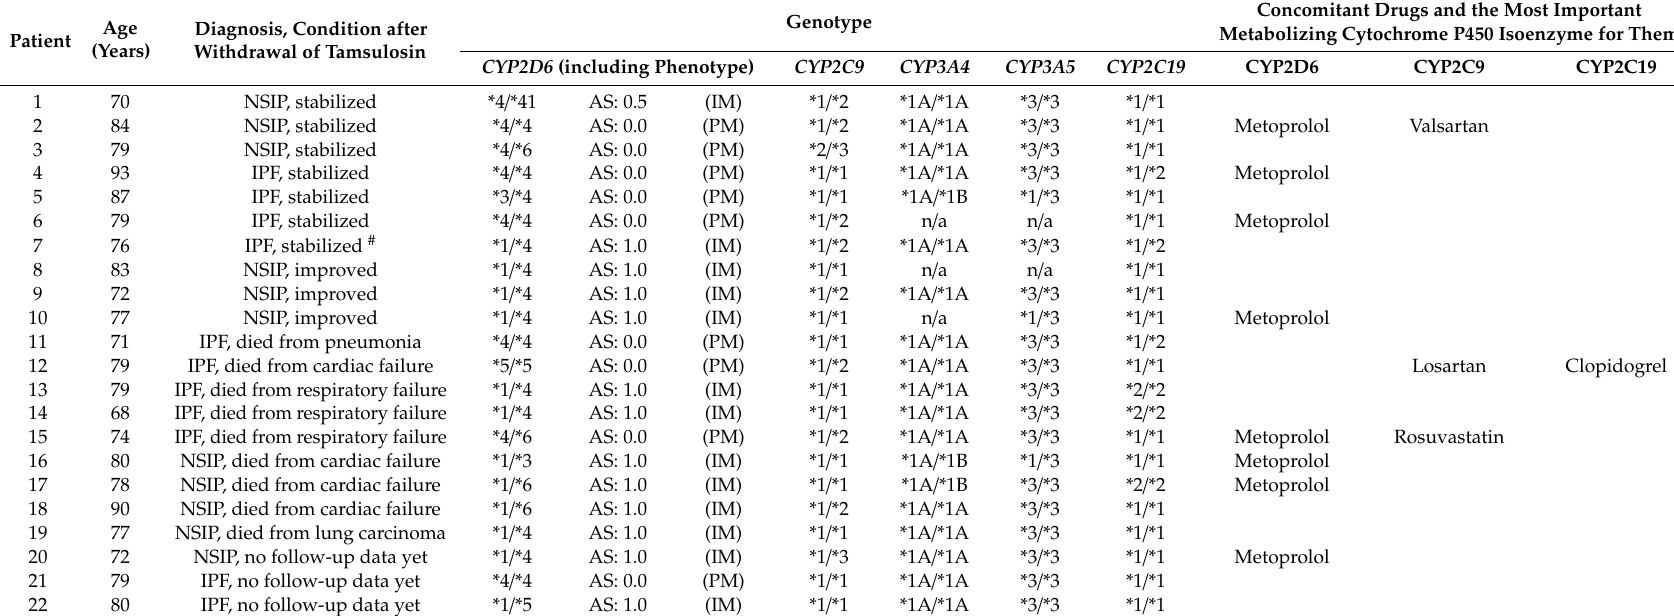
Table 1. Characteristics of the 22 patients with suspected tamsulosin-induced ILD. Abbreviations: NSIP = non-specific interstitial pneumonia; IPF = idiopathic pulmonary fibrosis; AS = activity score (range between AS = 0 (poor metabolizer) and AS > 2 (ultra-rapid metabolizer)); n / a = not available; PM = poor metabolizer; IM = intermediate